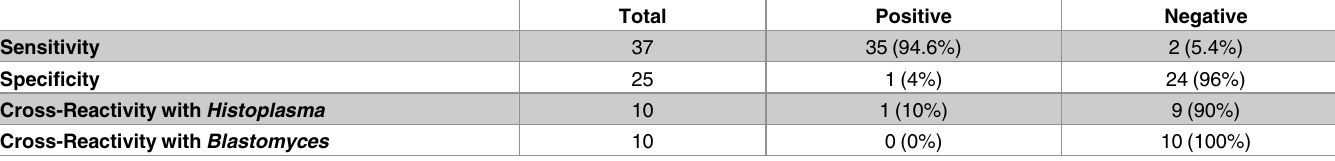
Total Positive Negative